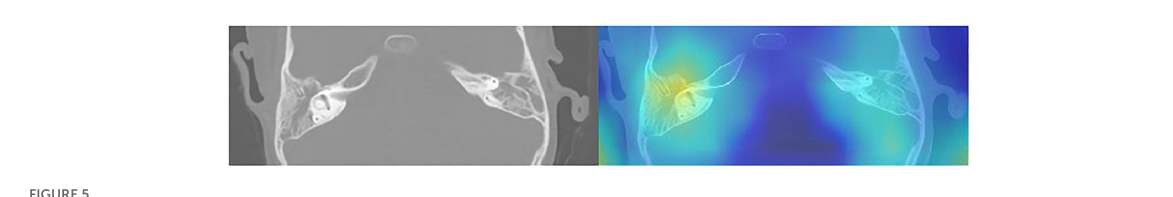
FIGURE5 CT of the temporal bone with MEI: Original image (left) and heat map (right) .